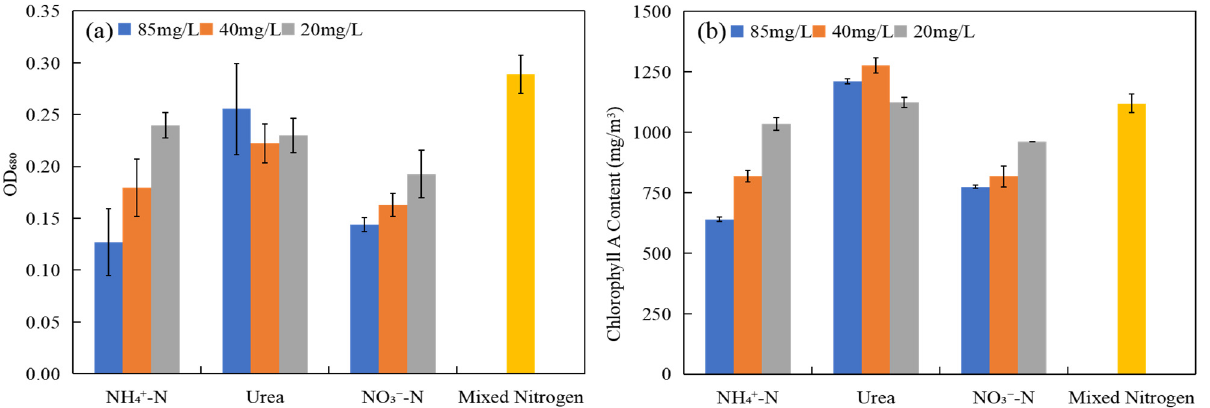
Figure 2. Growth of Scenedesmus dimorphus under different nitrogen sources and nitrogen concentrations: ( a ) OD 680 ; ( b ) chlorophyll a content ( n = 3).